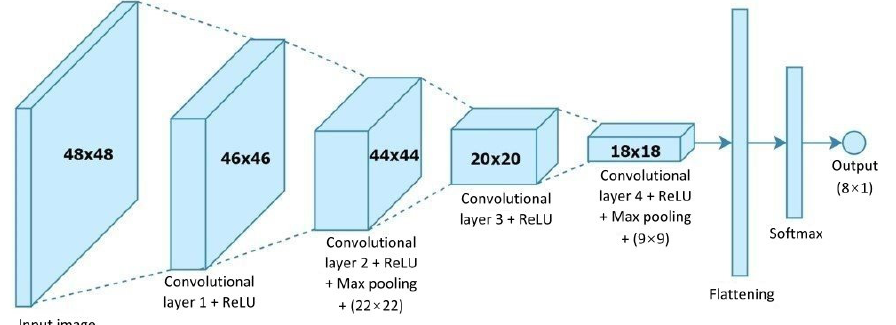
Figure 8. Flowchart of the human facial expression recognition system used in care robots.